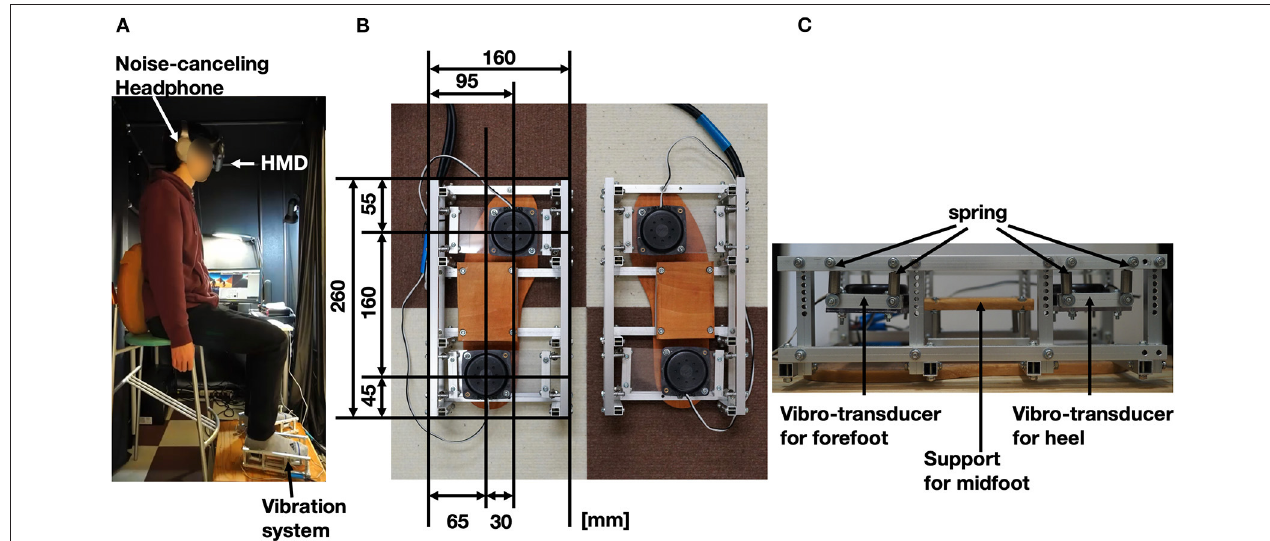
FIGURE 1 | Apparatus. (A) System overview. The participants, who sat on a stool, wore a head-mounted display (HMD) and placed their feet on the vibration system. (B) Top view of the vibration system that comprised four vibro-transducers. (C) Side view of the vibration system. Vibro-transducers were connected to the aluminum frame with springs to prevent transmission of